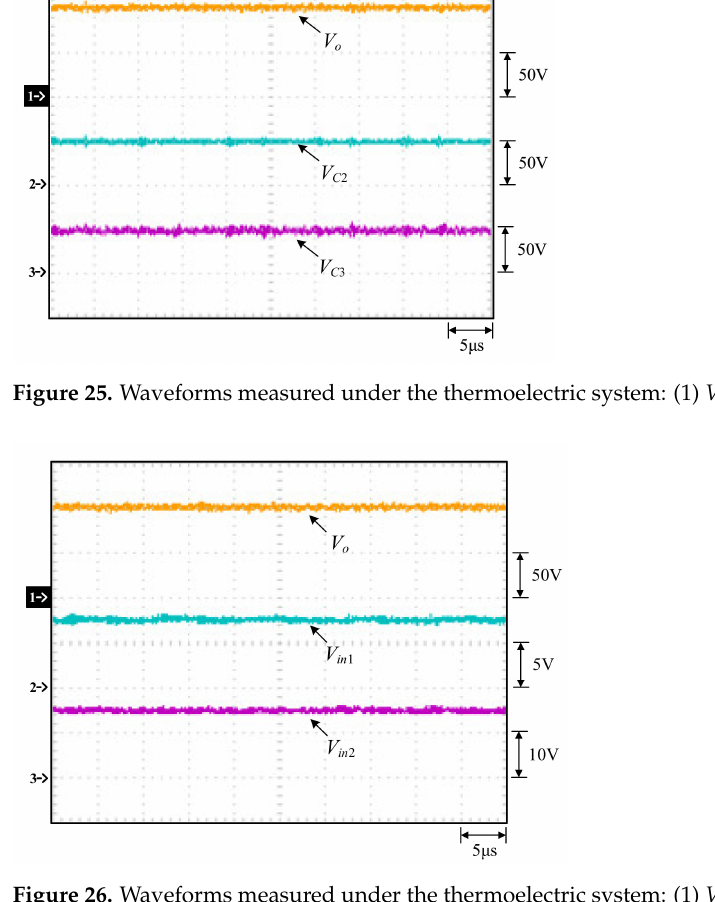
Figure 26. Waveforms measured under the thermoelectric system: (1) V o ; (2) V in 1 ; (3) V in 2